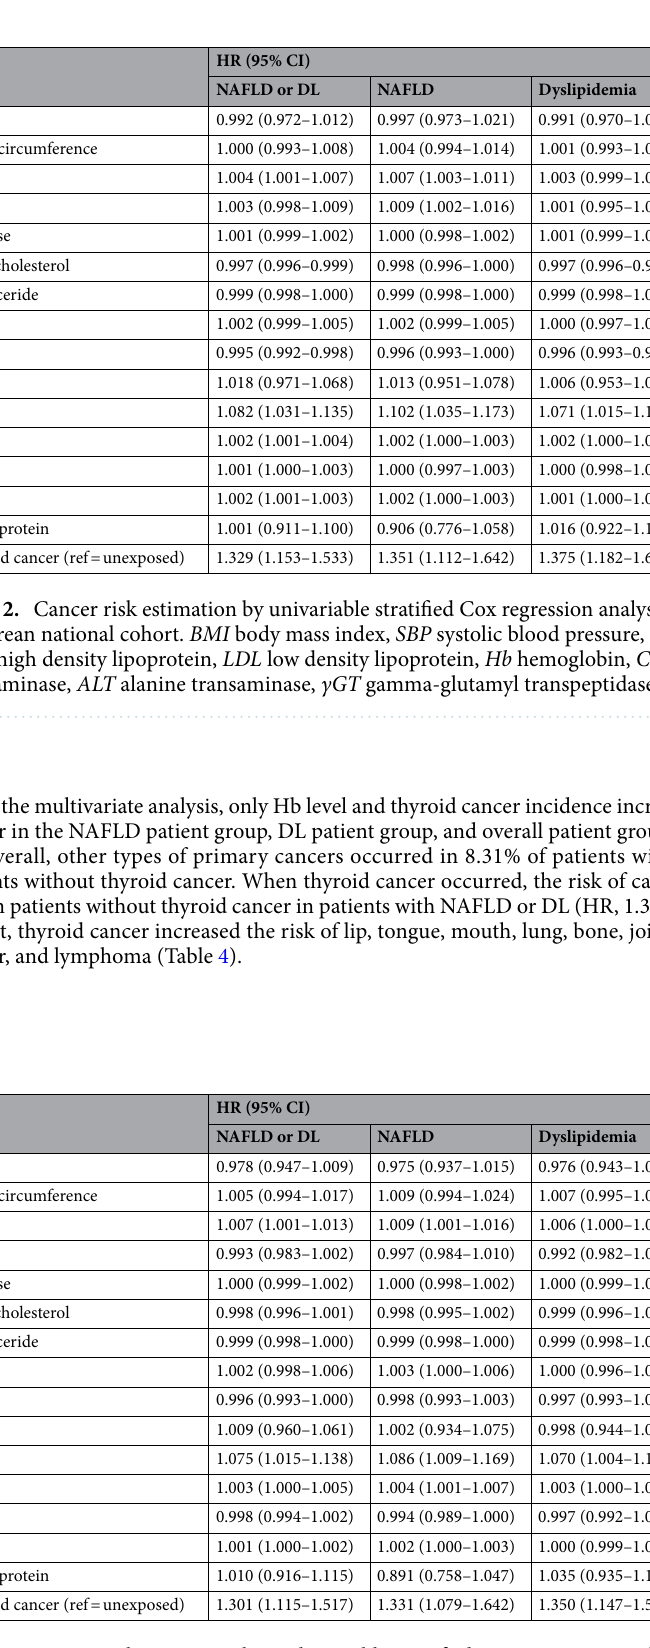
Table 3. Cancer risk estimation by multivariable stratified Cox regression analysis result after exact matching in Korean national cohort. BMI body mass index, SBP systolic blood pressure, DBP diastolic blood pressure, HDL high density lipoprotein, LDL low density lipoprotein, Hb hemoglobin, Cr creatinine, AST aspartate transaminase, ALT alanine transaminase, γGT gamma-glutamyl